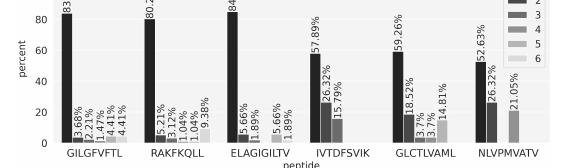
FIGURE 6 Peptide ranking analysis. Each positive TCR in the evaluation set was paired with all 6 peptides and predictions were obtained using the peptide-speci fi c models. For each TCR, the six prediction scores were sorted in descending order and a rank was obtained. A rank of 1 means that the model correctly predicted the true TCR-peptide pair, assigning the highest score. The bars in the plot show the proportion of TCRs for each rank